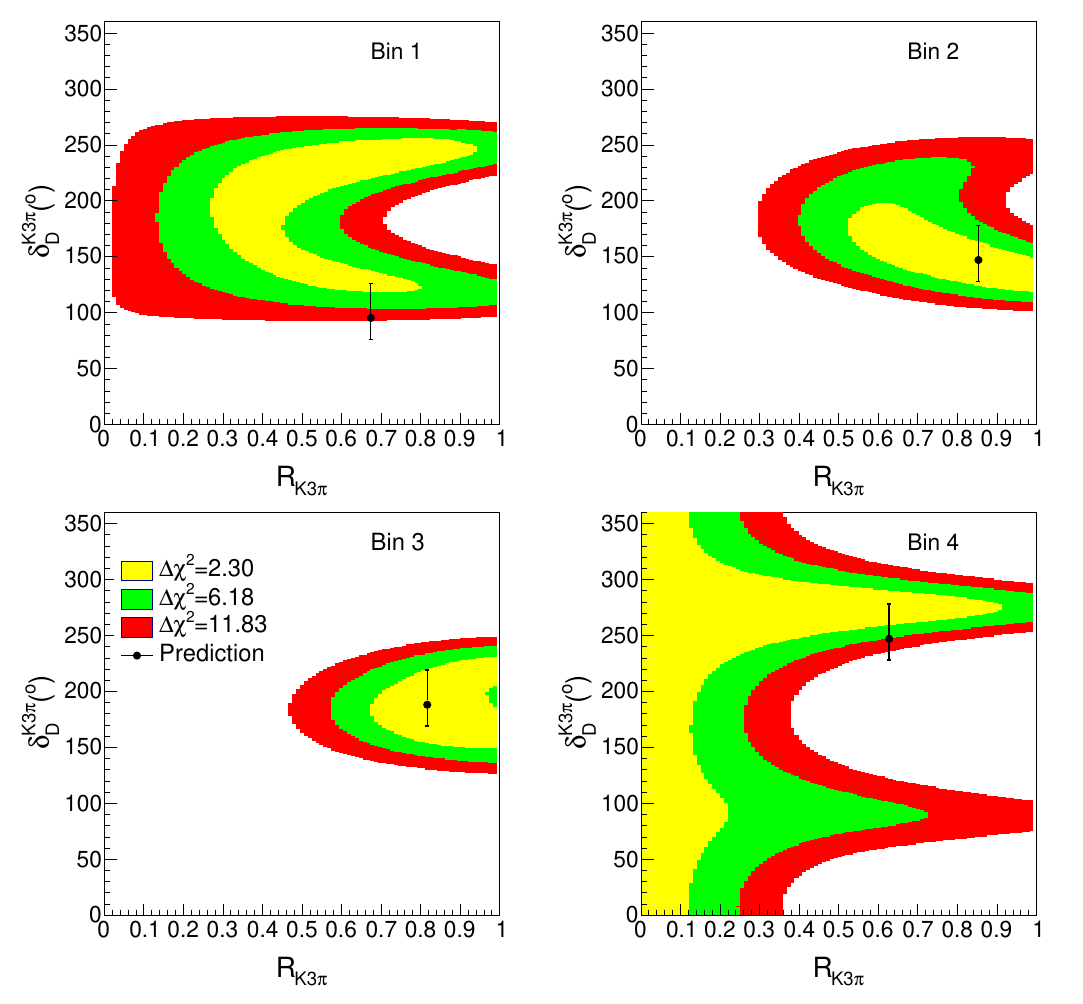
) parameter space, showing the Figure 10 . Scans of ∆ χ 2 in the four bins of the ( R K 3 π , δ K 3 π D ∆ χ 2 =2.30, 6.18, 11.83 intervals, which correspond to 68 . 3% , 95 . 4% and 99 . 7% confidence levels in the two-dimensional parameter space. Also indicated is the prediction from the model, where the global offset in the average strong-phase difference comes from the global